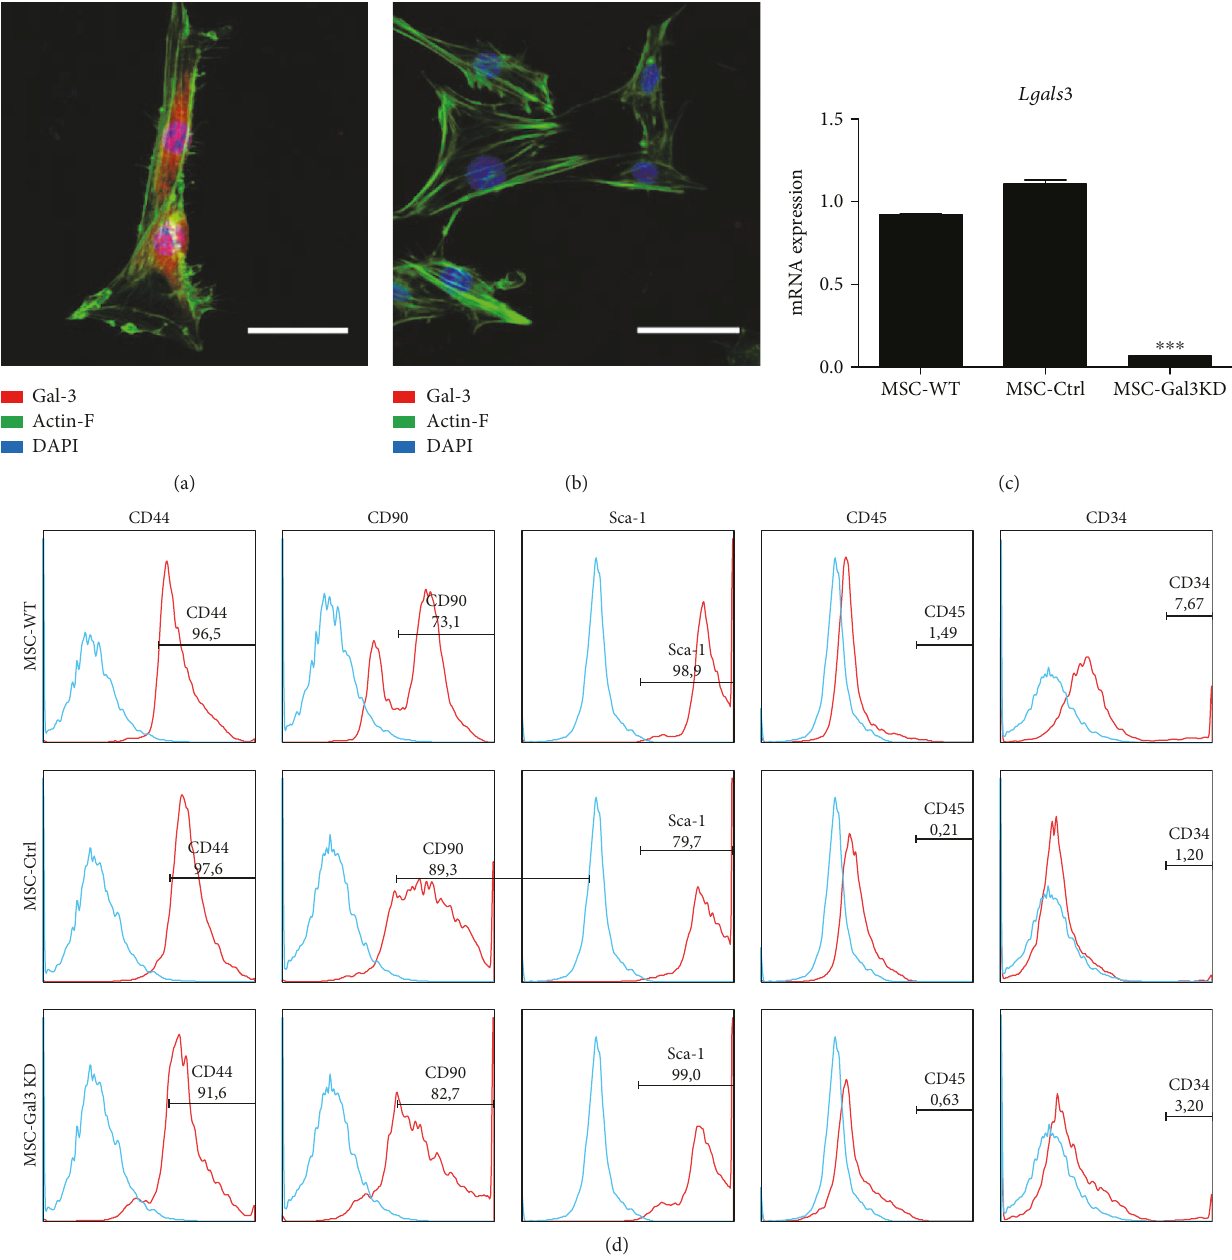
Figure 1: Evaluation of Gal-3 knockdown e ffi ciency and characterization of MSC lines. Confocal microscopy images showing Actin-F (green), Gal-3 (red), and nuclei stained with DAPI (blue) in wild-type (a) and Gal-3 knockdown MSC (b). Scale bars =20 μ m. (c) Gene expression analysis of Lgals3 by qRT-PCR. ∗∗∗ P < 0 001 , compared to the other groups. (d) Histograms demonstrating expression of surface marker characteristics of MSC and low expression of hematopoietic markers, analyzed by fl ow